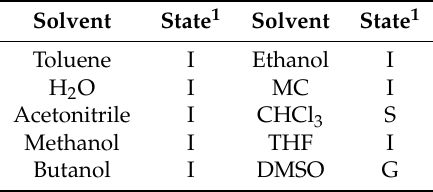
Table 1. Gelation test results of perylenediimide ( 1 ) at 0.5 equivalent of 2 (1 wt%). Solvent